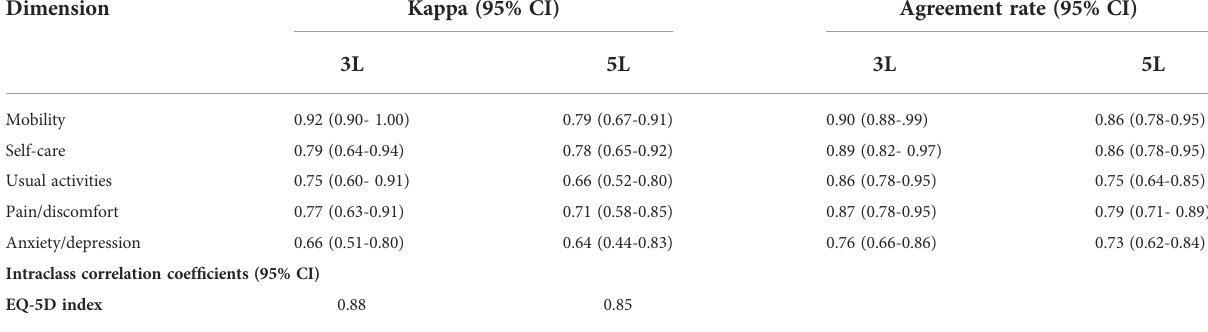
TABLE 7 Test – retest reliability of the 3L and 5L.